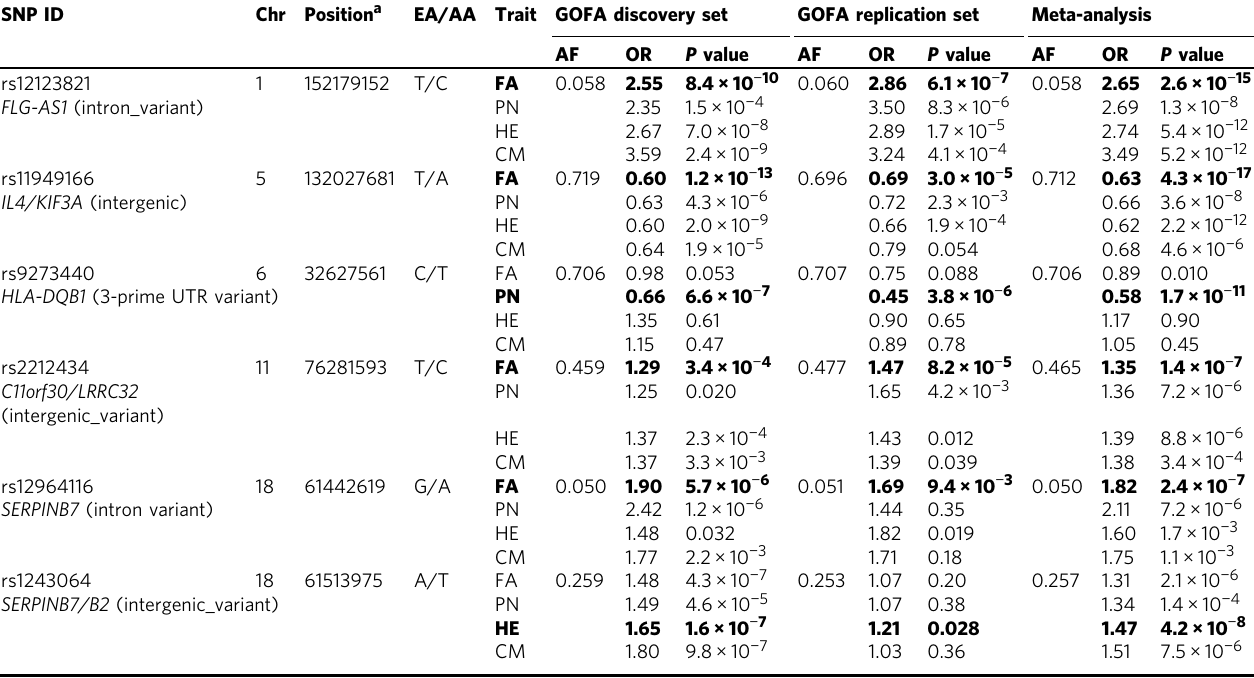
GOFA discovery set GOFA replication set Meta-analysisSNP